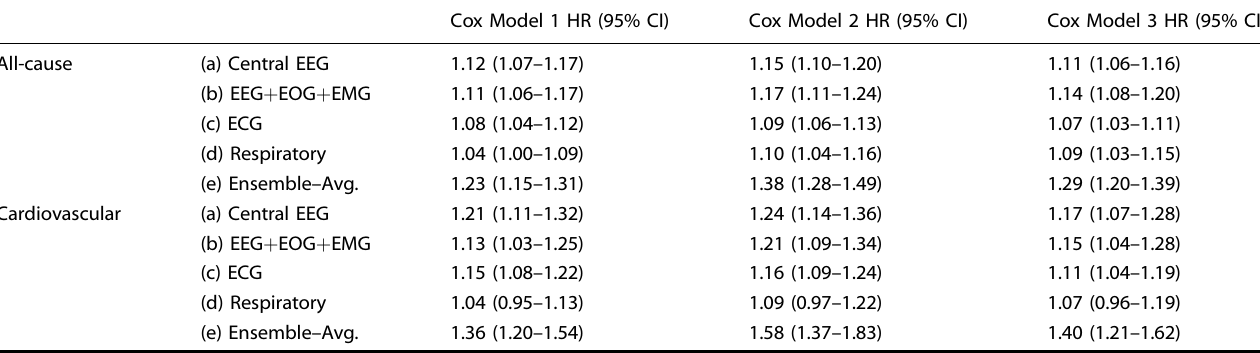
Table 2. Mortality hazard ratios per 10-year increment in AEE in the combined data of the Sleep Heart Health Study, the Wisconsin Sleep Cohort, and the MrOS Sleep Study.